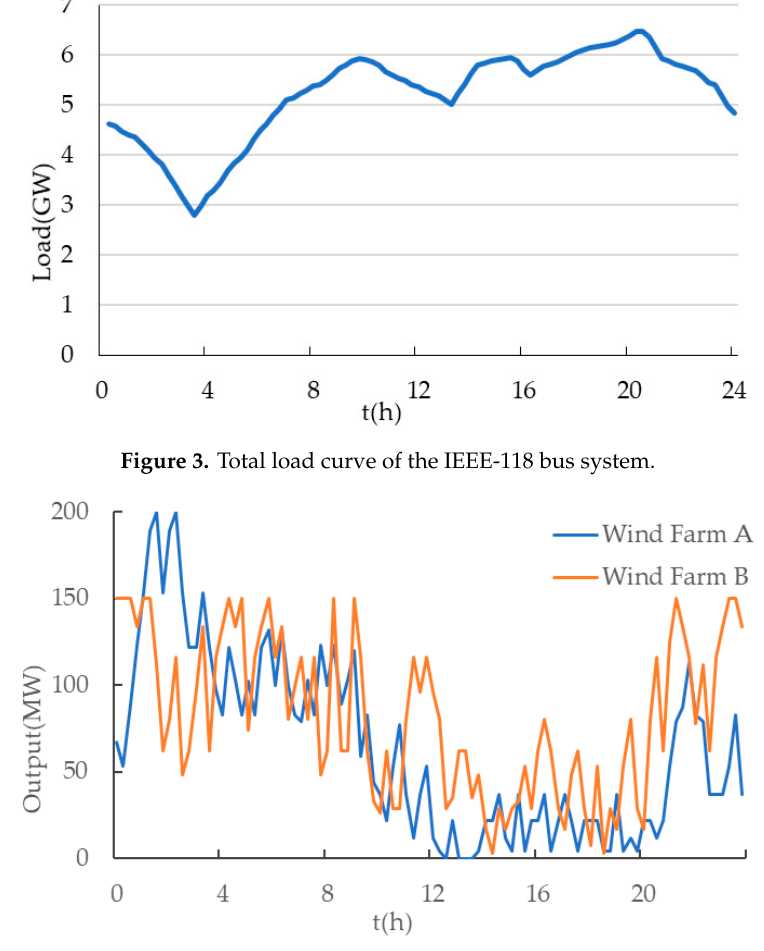
Figure 4. Output data of two wind farms in northwest China.